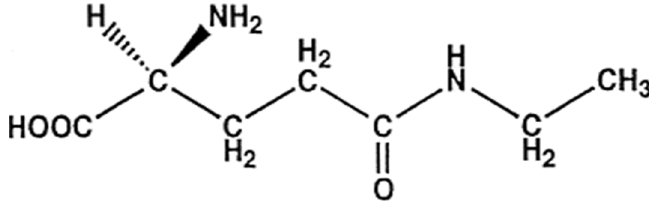
Figure 1. Chemical structure of L -THE. Adapted from [5].